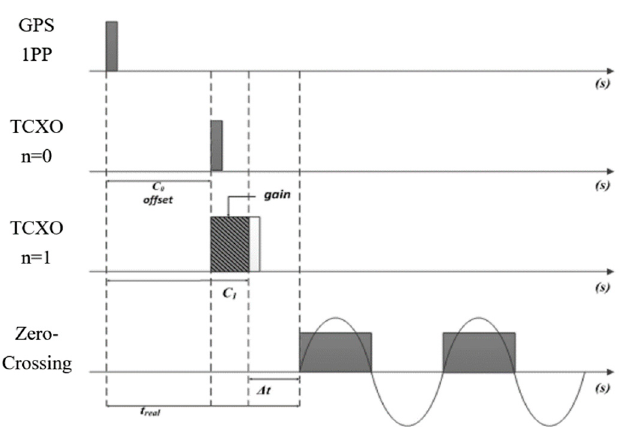
Figure 6. Principle of TCXO compensation.